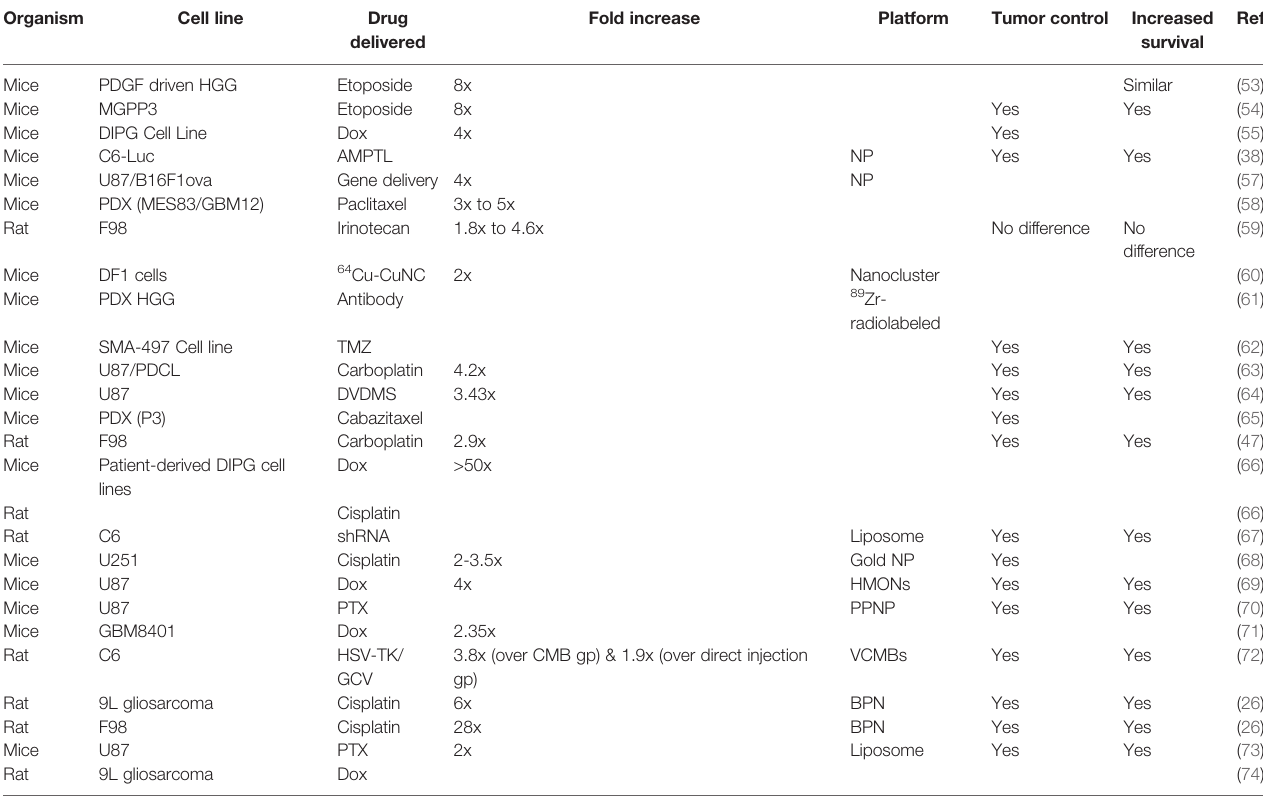
TABLE 6 | List of drugs delivered to experimental animals bearing different cell lines of glioblastomas in preclinical studies.